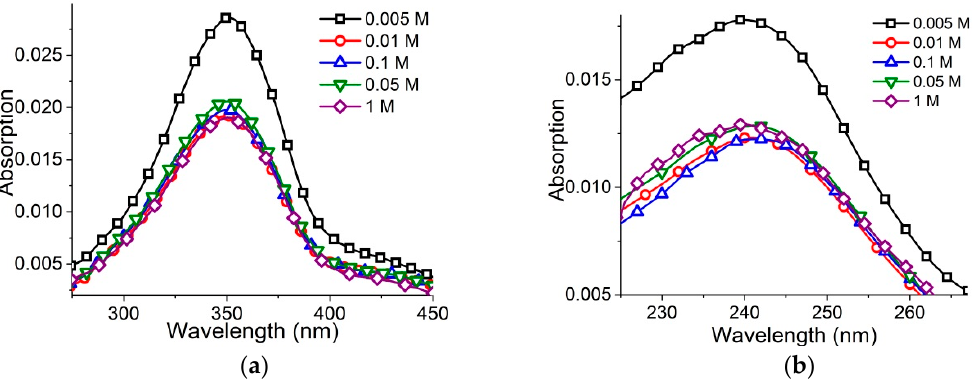
Figure 3. Surfactant absorbance bands ( a , b ) at varied [NaCl] (as depicted) and [AzoTAB] = 2 × 10 − 6 M. This surfactant concentration excludes the emergence of micelles even at [NaCl] = 1 M.